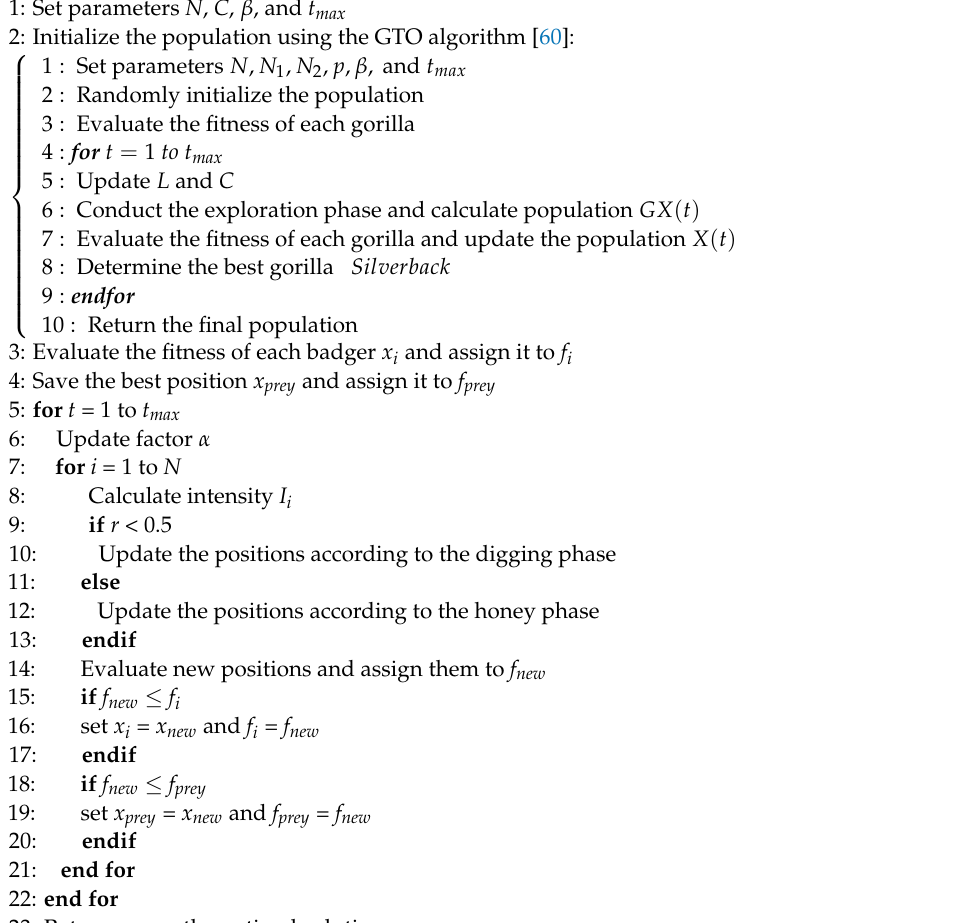
Algorithm 1: Complete pseudo-code of the artificial gorilla troops optimizer-honey badger algorithm (GTO-HBA) (Proposed